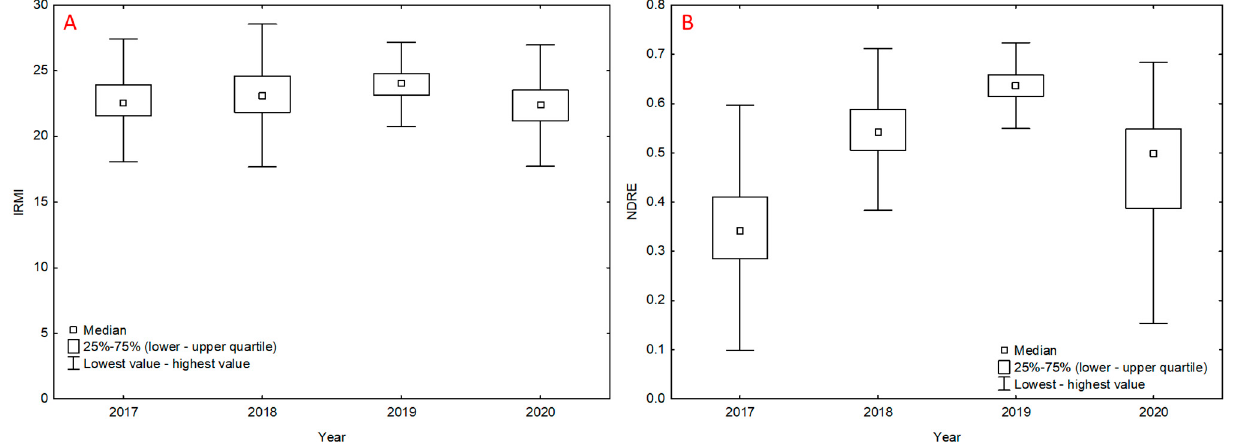
Figure 5. Average values of IRMI (part of graph ( A )) and NDRE (part of graph ( B )) vegetation indices in 2017–2020: Boxes show Quarter 1 (25%) and Quarter 3 (75%), red squares show the median and black brackets show minimal and maximal values. Table 4. Results of descriptive statistics—vegetation indices for the period 2017–2020.